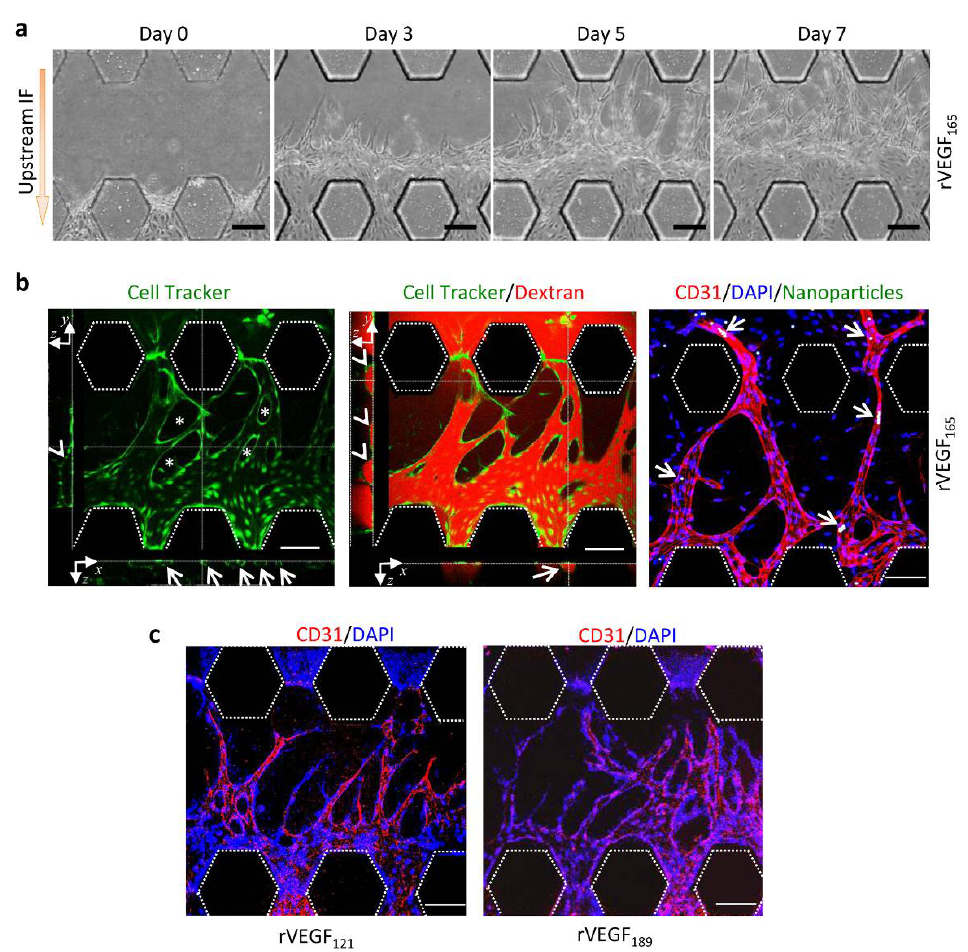
Figure 5. Functional vessels induced by rVEGF 121 , rVEGF 165 , and rVEGF 189 . ( a ) Images of vascular sprouts induced by rVEGF 165 in the presence of upstream IF with time. ( b ) Vessel morphology. Cells were stained with CellTracker (green). Several vessel loops (*) could be observed. X−z cross-sectional image showed that five vessels were hollow and lined by a layer of cells (arrows). Y−z cross-sectional image showed that a hollow vessel was lined by a layer of cells (arrowhead) (left). Dextran permeability assay. X−z (arrow) and y−z (arrowheads) cross-sectional images showed that TRITC-dextran (red) was enclosed in vessels by pHUVEC (green) (middle). Nanoparticle tracking assay (right): Nanoparticles (arrows, white) entrapped in newly formed vessels, which were positive for CD31. ( c ) CD31-positive vessels induced by rVEGF 121 and rVEGF 189 . Scale bar = 100 μm.